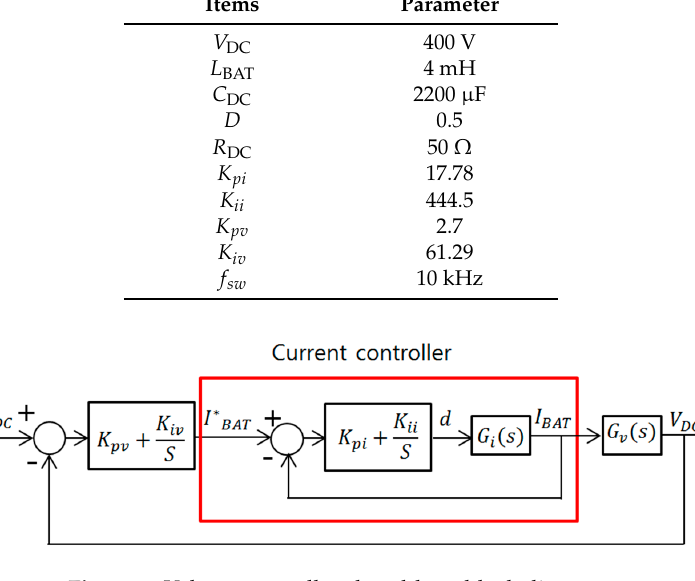
Figure 6. Voltage controller closed-loop block diagram.